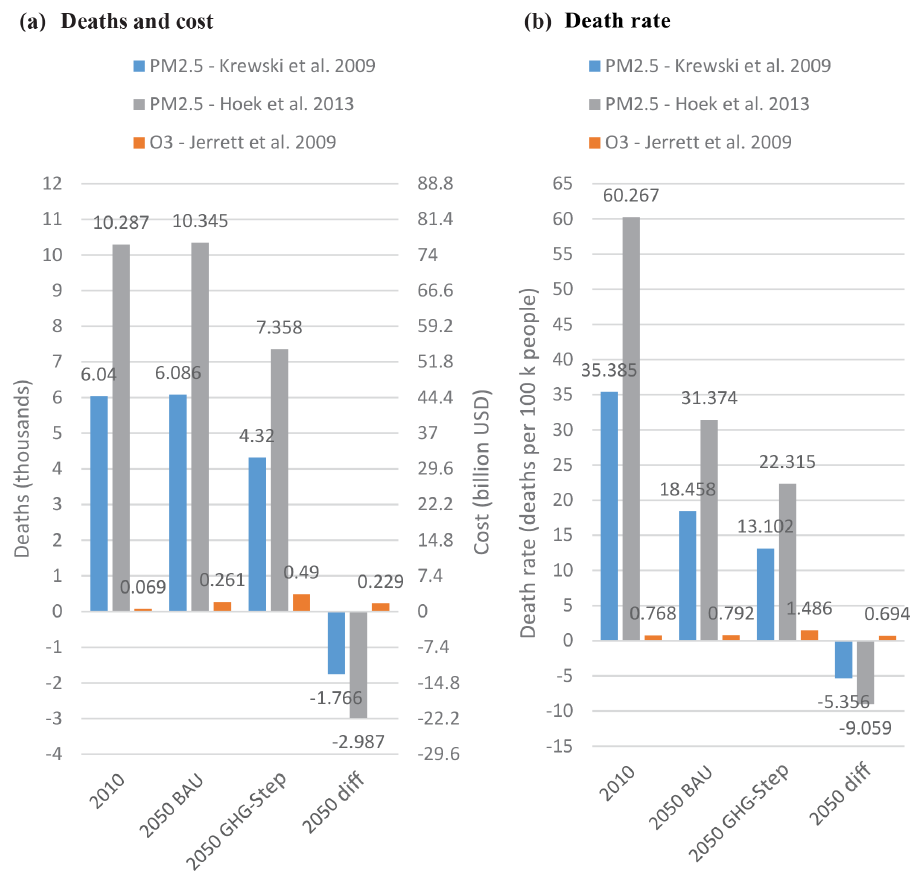
Figure 7. (a) Deaths and cost and (b) death rate for the high-resolution modeling domains covering 93% of California’s population. PM 2 . 5 damages are estimated using methods derived by Krewski et al. (2009) (blue bars) and Hoek et al. (2013) (gray bars). Ozone damages are estimated using the methods derived by Jerrett et al. (2009) (orange bars). Only bars with the same color should be compared between 2010, 2050 BAU, and 2050 GHG-Step. The “2050 Diff” category shows the difference between the 2050 GHG-Step and BAU